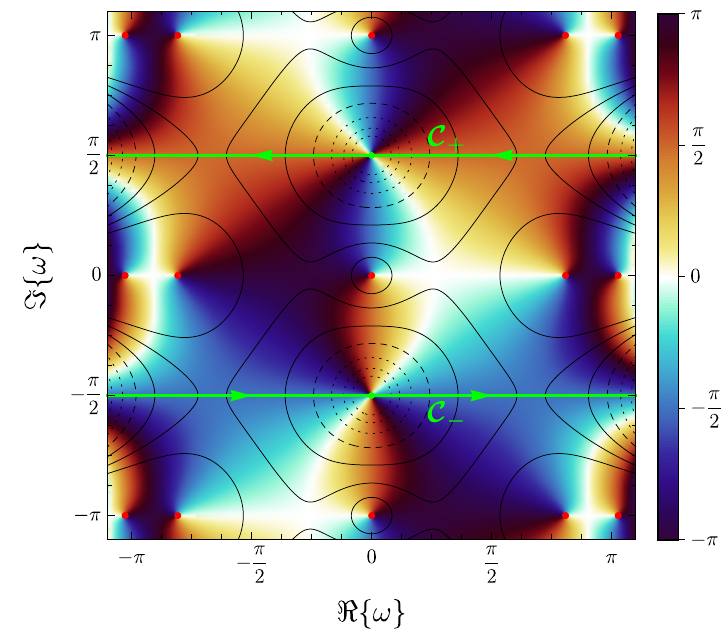
in the hyperbolic m + C + − . Here no